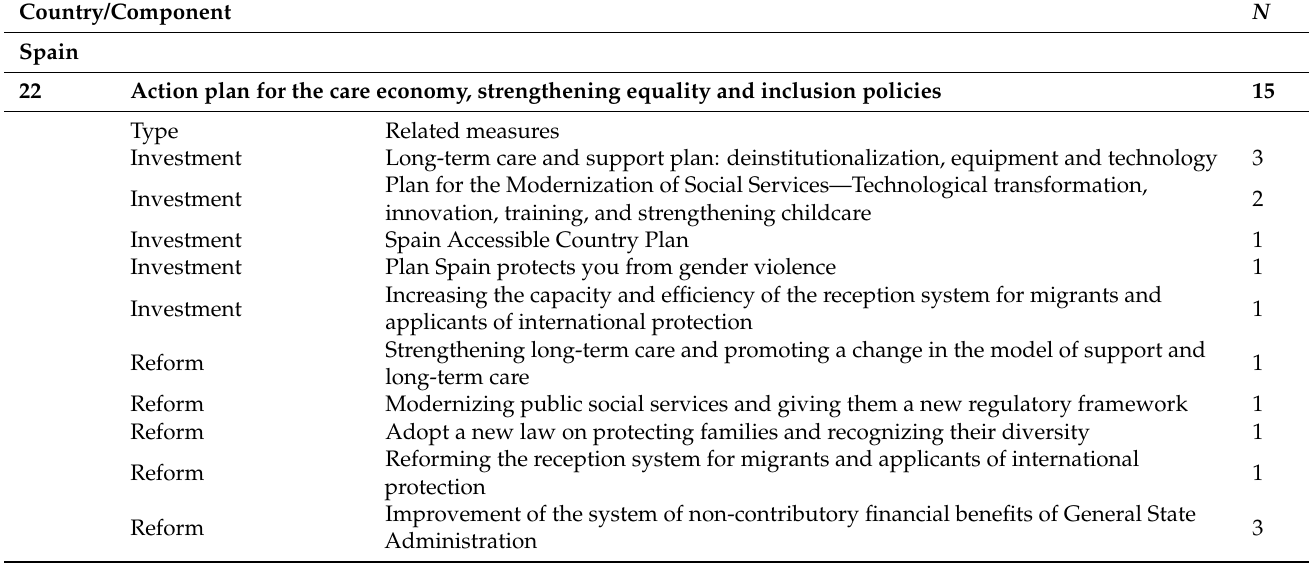
Table 5. Social and employment protection measures in the Spanish recovery and resilience